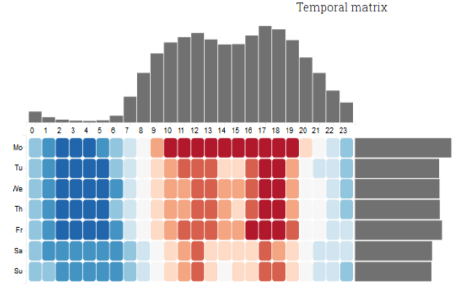
Figure 5. Temporal matrix . Time grid showing the representation of a typical week in the selected